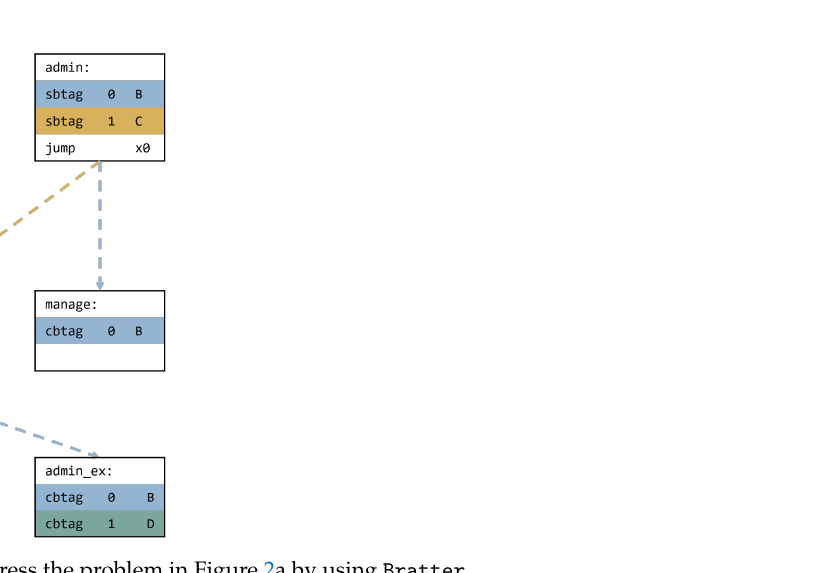
Figure 6. Address the problem in Figure 2a by using Bratter